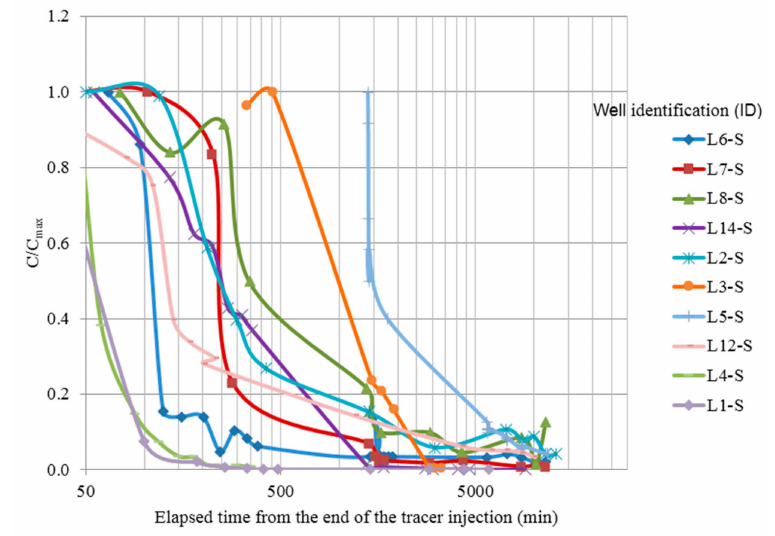
Figure 4. Breakthrough curves of relative tracer (chlorophyllin) concentrations during injection tests in ten boreholes of Bari aquifer. Table 1. Network of monitored wells at the Bari fractured aquifer: Pumping and tracer test results. Well